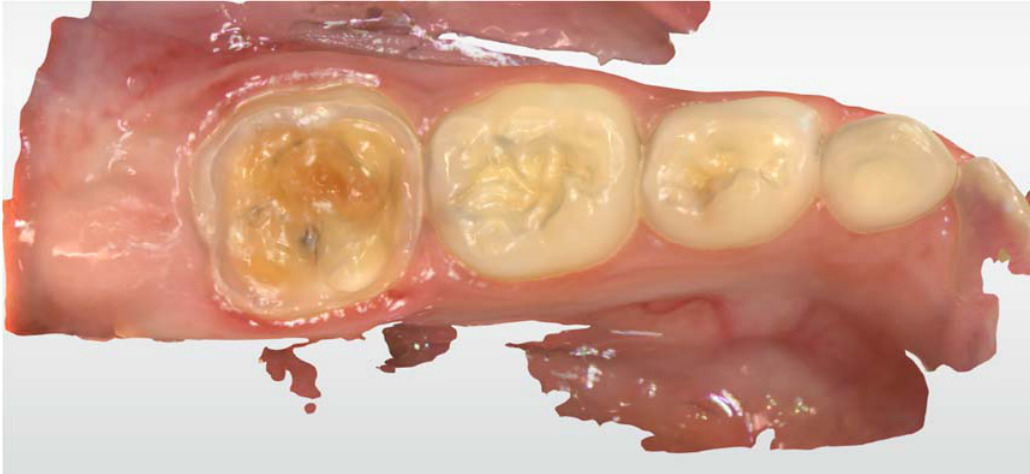
Figure 3. A scan of tooth #16 after tooth preparation.